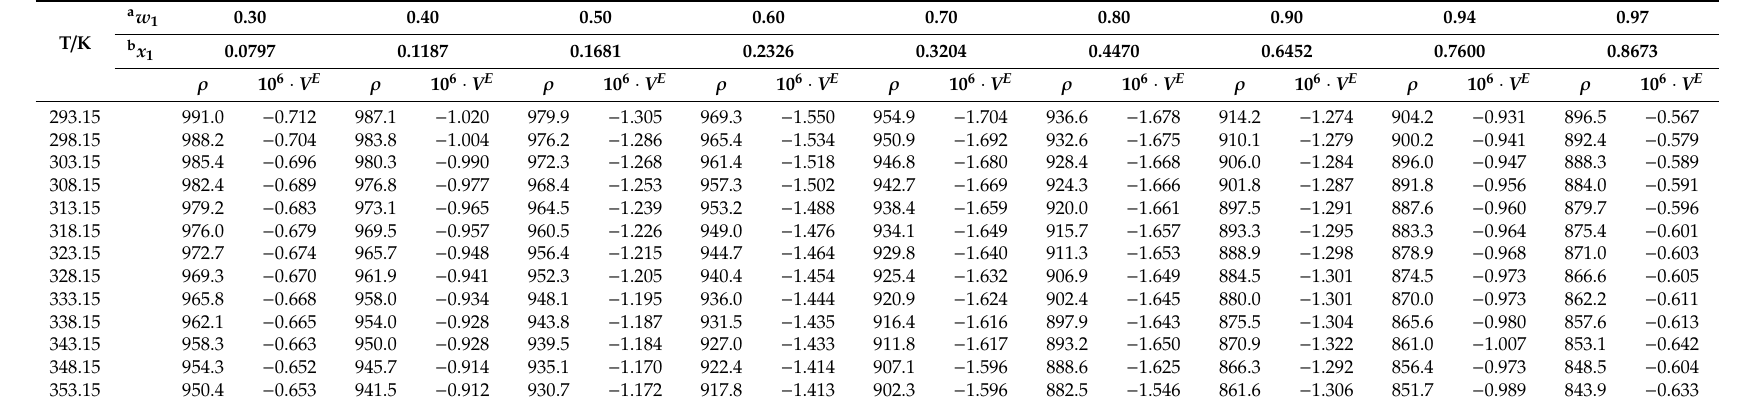
Table A2. Measured density ( ρ / kg · m − 3 ) and deduced excess molar volume ( V E / m 3 · mol − 1 ) of DMEA (1) + H 2 O (2)